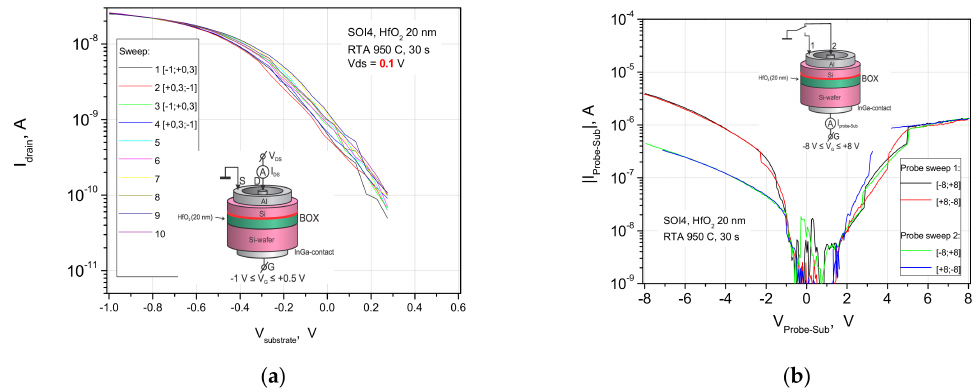
Figure 4. ( a ) Drain-current-gate voltage characteristics of the n-SIS (500 nm n-Si/20 nm HfO 2 /Si substrate) pseudo-MOSFETs after the RTA at 950 ◦ C for a scan of V g = − 1.0 + 0.6 V; ( b ) current-voltage characteristics at the source-gate and drain-gate contacts, bias voltages in the range V g = − 8 + 8 V.